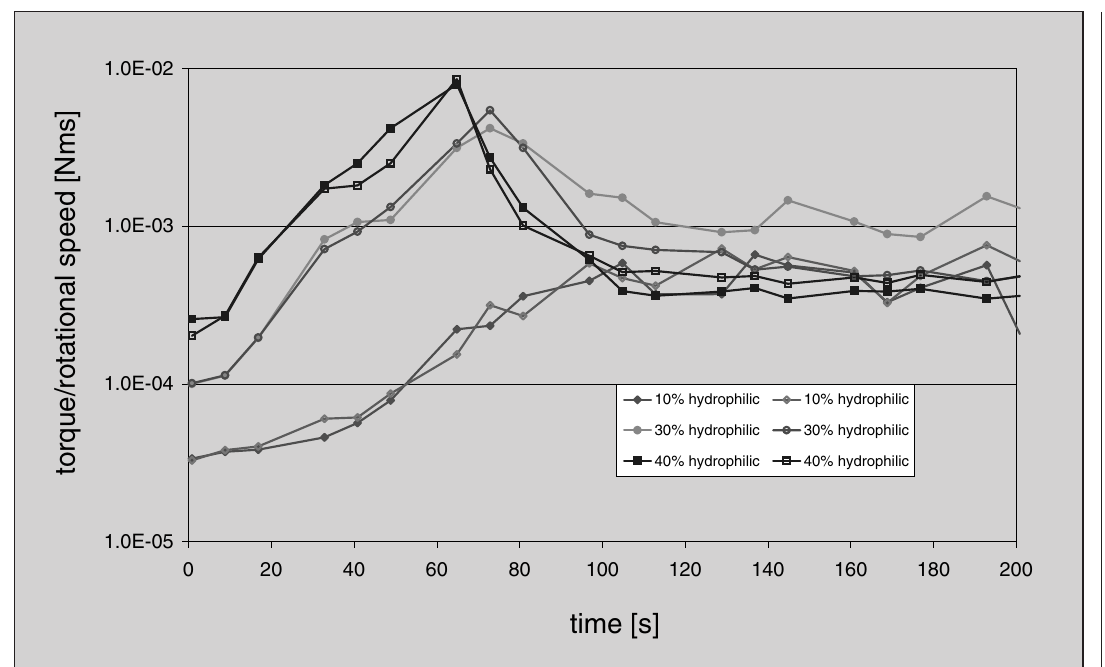
Figure 3: Viscosity versus time as recorded during the mixing of a hydrophilic glass sphere suspension with a w/o emulsion at 0.48 rev/s and varying glass beads